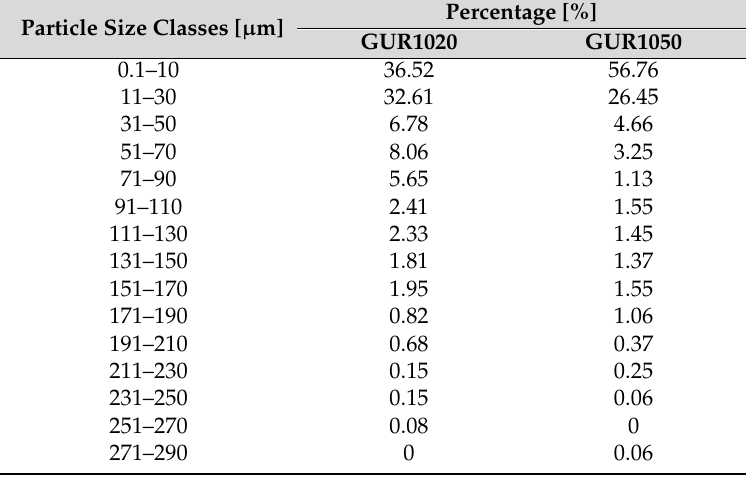
Table 1. Particle size distribution of the di ff erent GUR types [N =